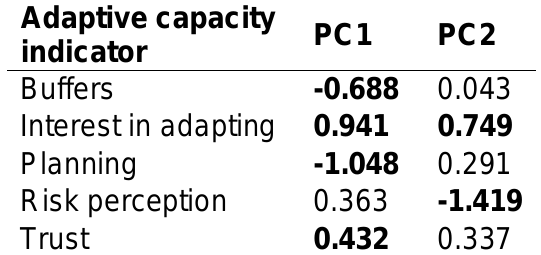
Table S3. Factor loadings for each adaptive capacity indicator on PCA axes. Factor loadings greater than 0.4 (bold) on any given principal component are generally considered to contribute substantially to that component.